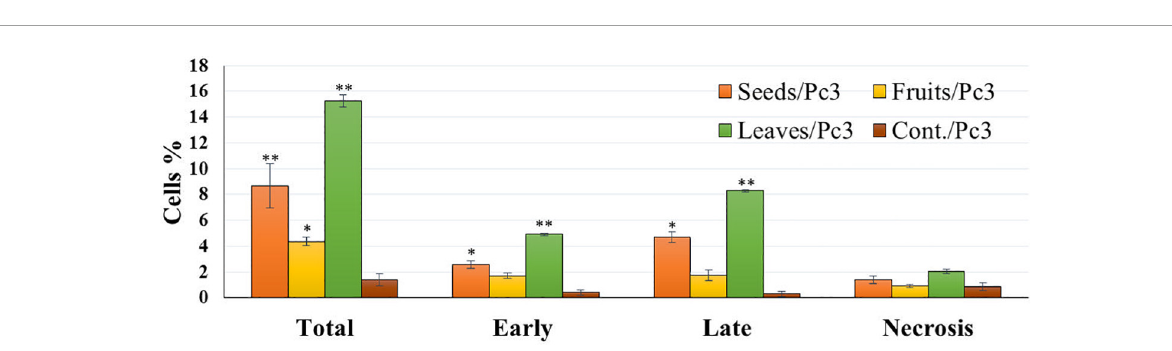
groups. Additionally, the concentration of 5,000 µ g/mL from seed extract showed high cytotoxic effects on the Panc1 cell lines ( Figure 10 ).